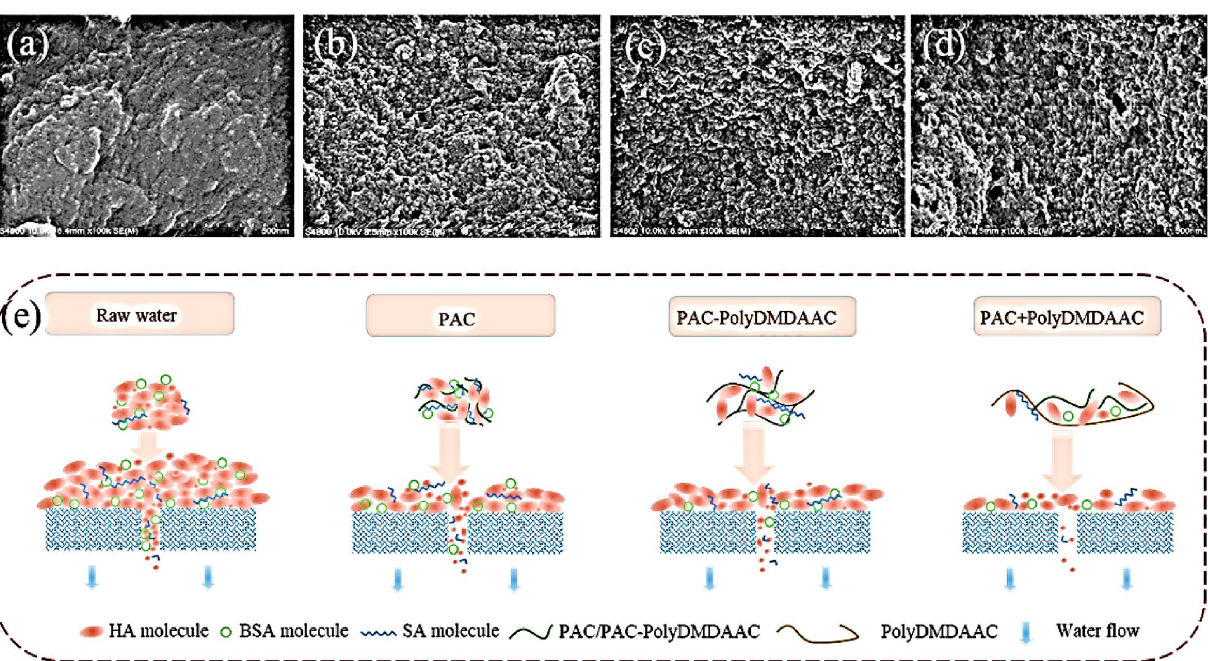
Figure 16. SEM images of the cake layer in the membrane surface created by: ( a ) no pretreatment; ( b ) PAC coagulation system; ( c ) PAC-PolyDMDAAC coagulation system; ( d ) PAC + PolyDMDAAC dual coagulation; ( e ) a schematic of the likely process of membrane fouling by different coagulation systems [108].